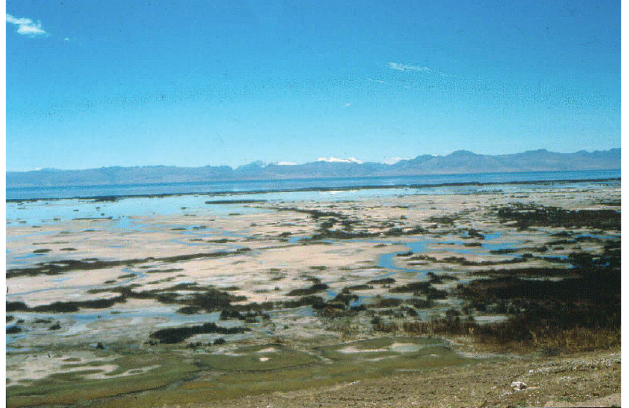
Figure 2. Marl exposed during the dry season along the western edge of Lake Junin; view is looking east across the lake to the eastern cordillera. The marl exposed in this photograph has precipitated on the leaves of rooted macrophytes and has accumulated to form a bioherm several meters thick. The glacier-clad summits in the distance fed valley glaciers that reached the eastern edge of Lake Junin on several occasions in the last million years (Smith et al., 2005a, 2005b).